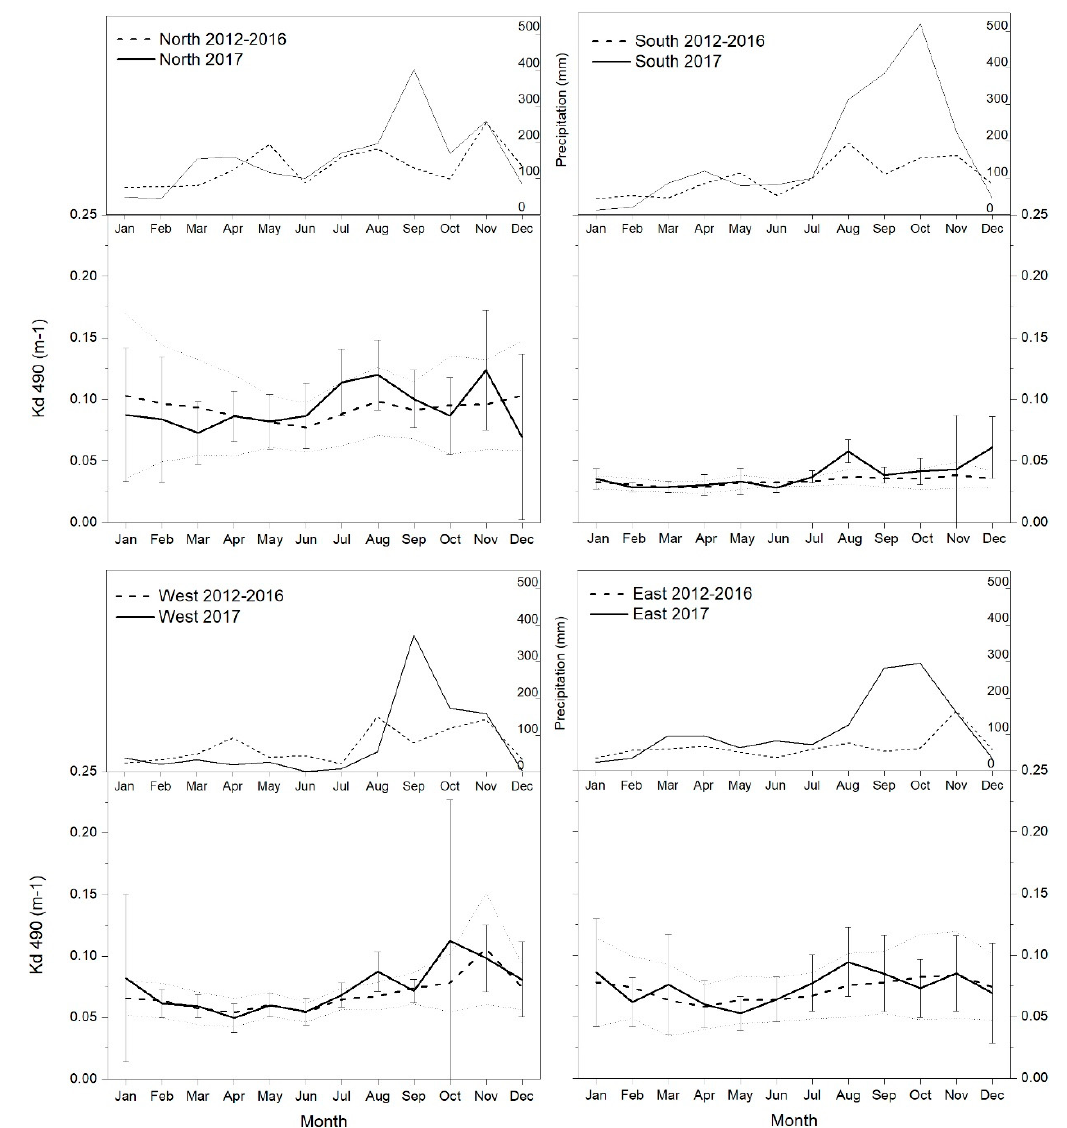
Figure 7. Monthly averaged precipitation and K d 490 with standard deviation by regions for 2012–16 baseline period and 2017.